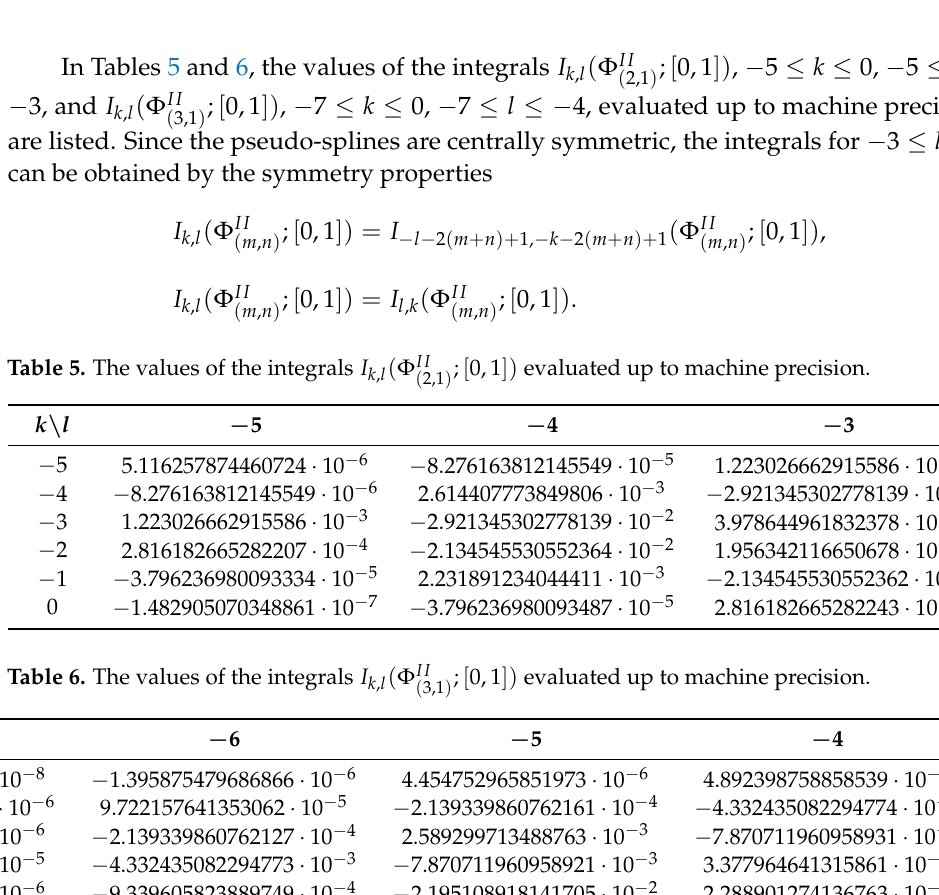
Table 7. The values of the integrals I k , l ( D x Φ II